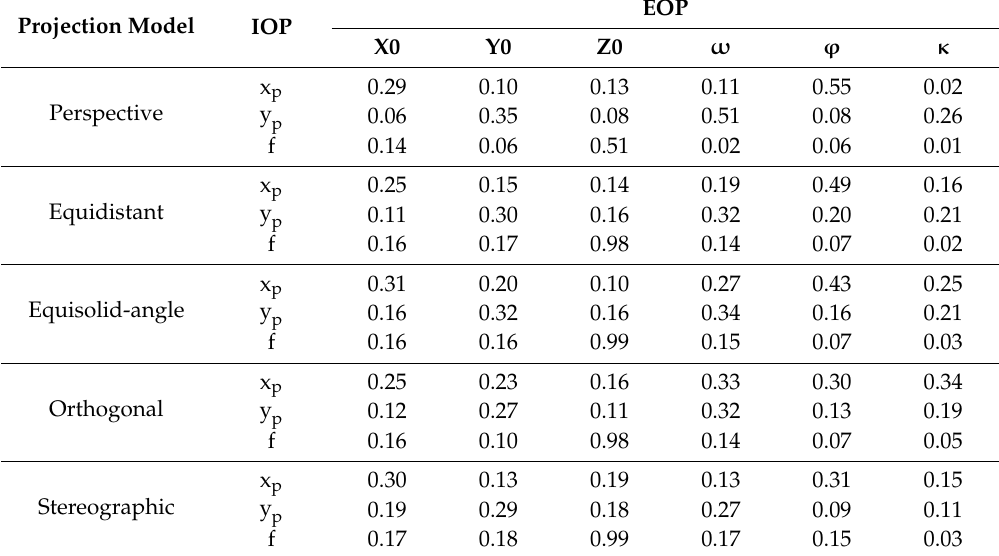
Table 8. Correlation between the orientation parameters (A-type test